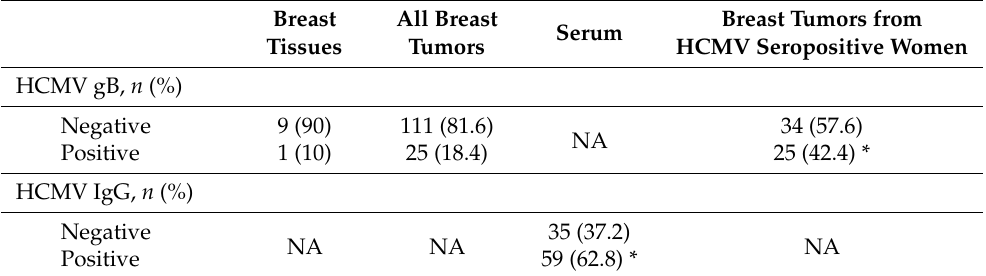
Table 2. Detection of HCMV DNA in tissues and IgG in serum of patients.